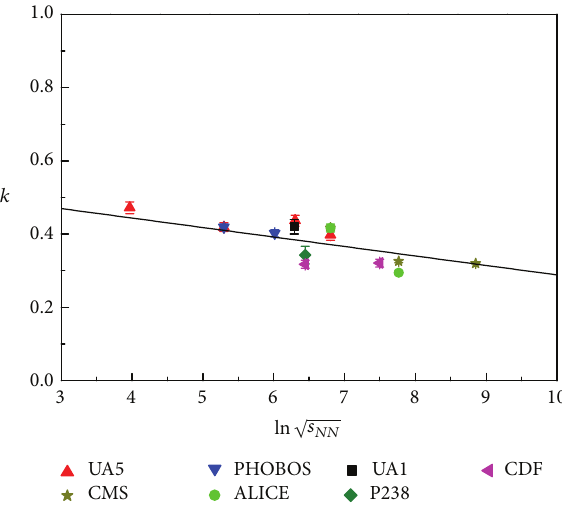
Figure 6: Correlations between 𝑘 and ln √ 𝑠 𝑁𝑁 , where √ 𝑠 𝑁𝑁 is in the units of GeV. The symbols represent the values of contribu- tion ratio 𝑘 of projectile (or target) participant quark component obtained in Figures 1–3 and listed in Table 1, and the line is our fitted